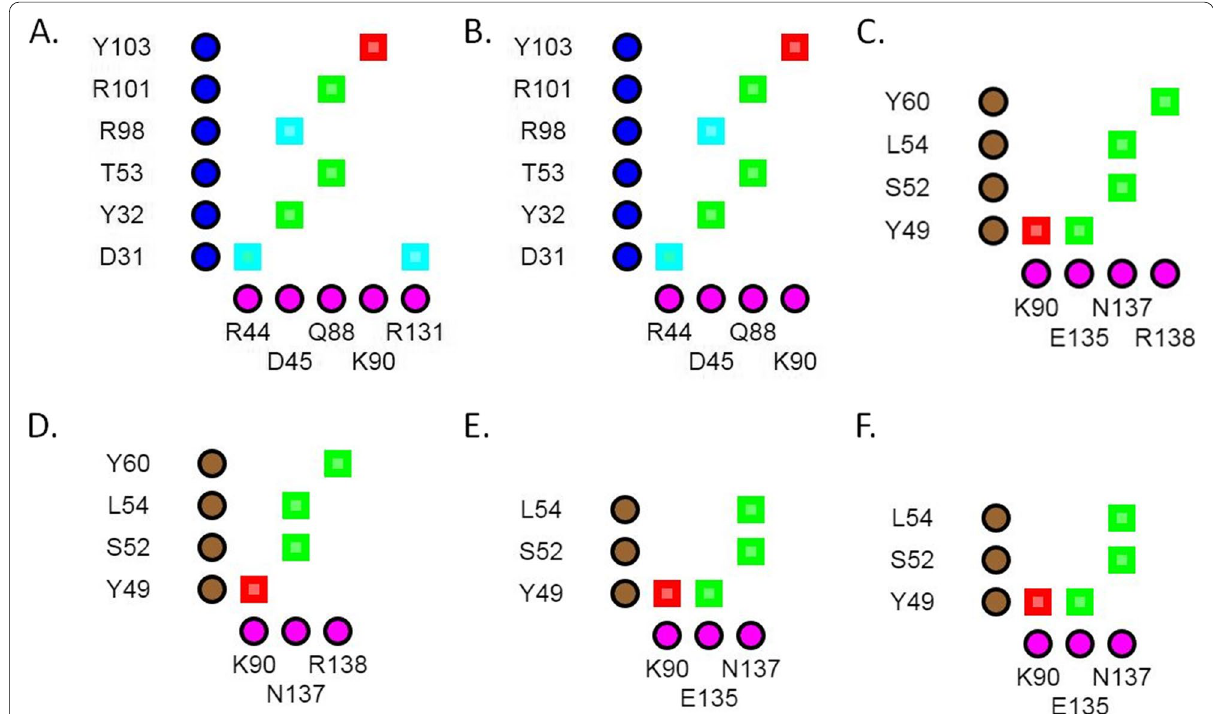
Fig. 3 Interactions between TNFA and certolizumab pegol. 2D plots of interactions between TNFA and the heavy chain of certolizumab pegol in the wild-type ( A ) and TNFA R131Q variant ( B ) structures. 2D plots of interactions between TNFA and the light chain of certolizumab pegol in the wild-type ( C ), TNFA E135G ( D ), TNFA R138Q ( E ), and TNFA R138W ( F ) variant structures. TNFA residues are shown along the horizontal axis and certolizumab pegol residues are delineated along the vertical axis. Green- hydrogen bonds; cyan- salt bridges/ionic interactions; and red- cation-pi interactions